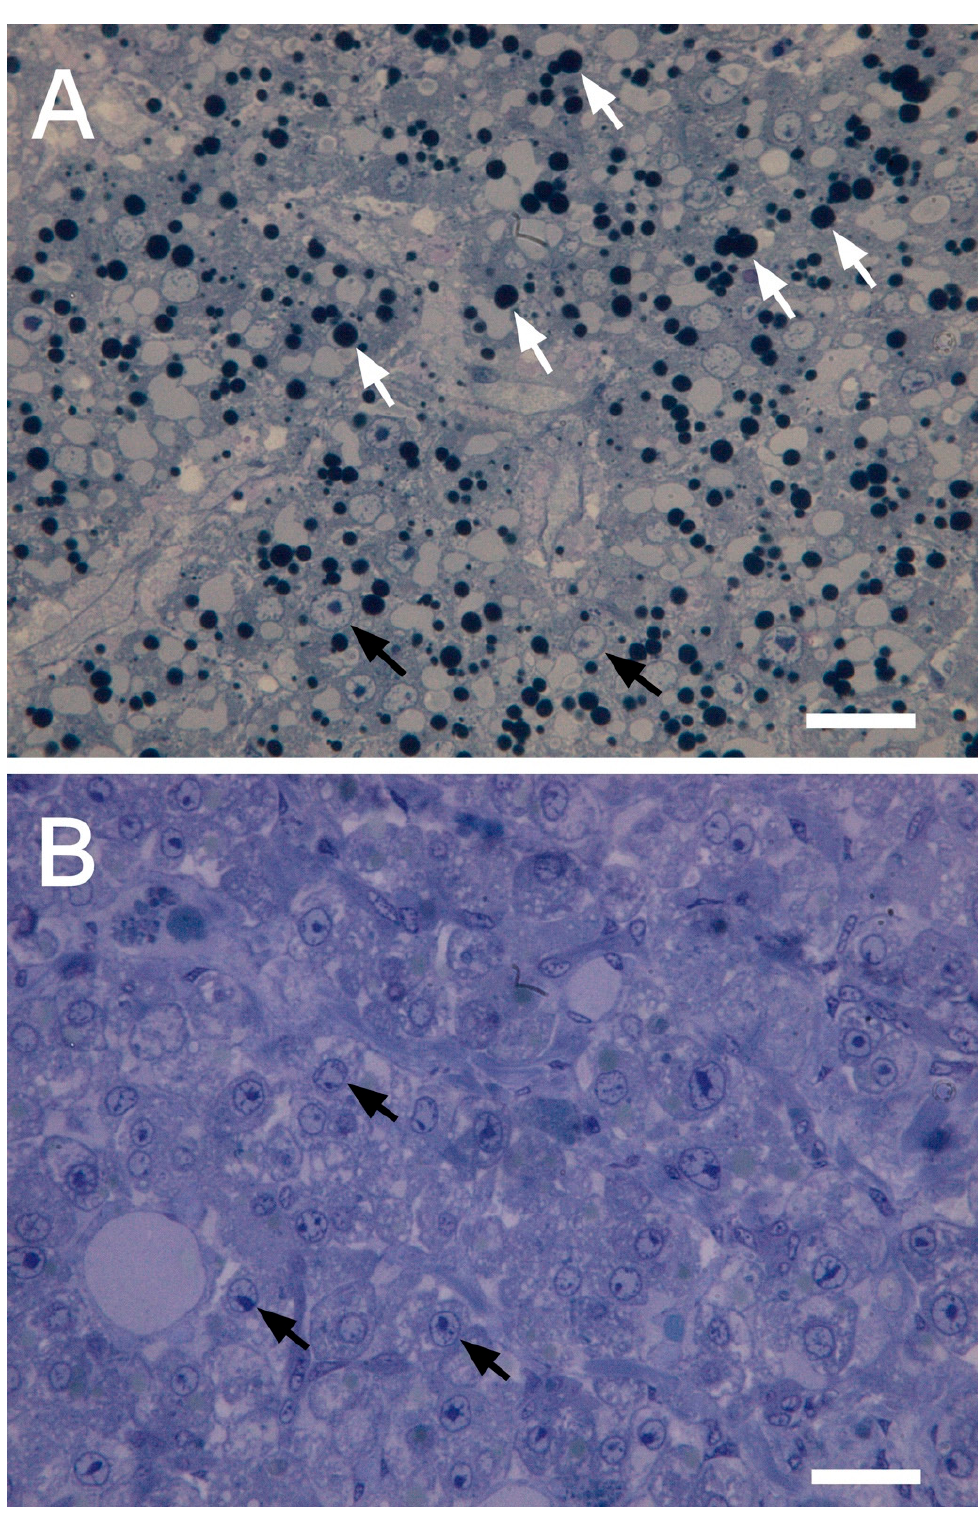
Figure 4. Semi-thin liver sections of C. gobio ; ( A ) liver parenchyma showing massive lipid droplets (male, June, But Stream). ( B ) liver parenchyma without lipid droplets (male, June, Dimon Lake). Black arrows: nuclei; white arrows: lipid droplets. Calibration bar = 20 µm.